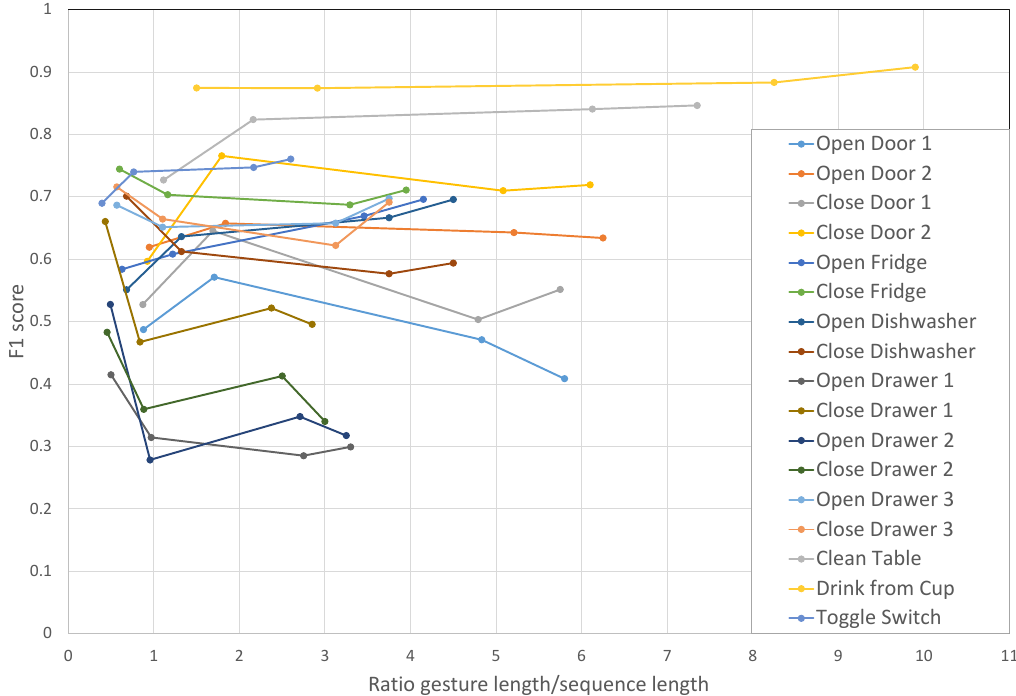
Figure 7. F 1 score performance of DeepConvLSTM on the OPPORTUNITY dataset. Classification performance is displayed individually per gesture, for different lengths of the input sensor data segments. Experiments carried out with sequences of length of 400 ms, 500 ms, 1400 ms and 2750 ms. The horizontal axis represents the ratio between the gesture length and the sequence length (ratios under one represent performance for gestures whose durations are shorter than the sequence